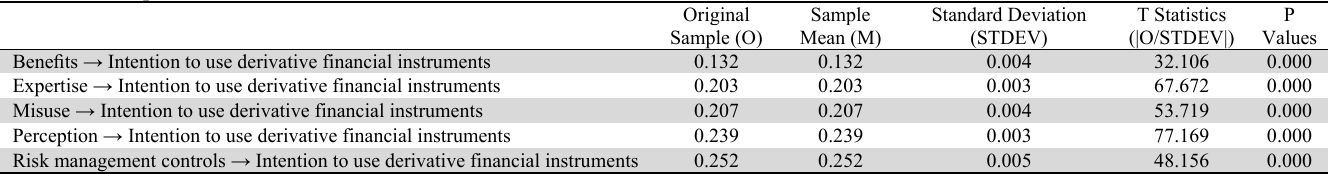
The results of path